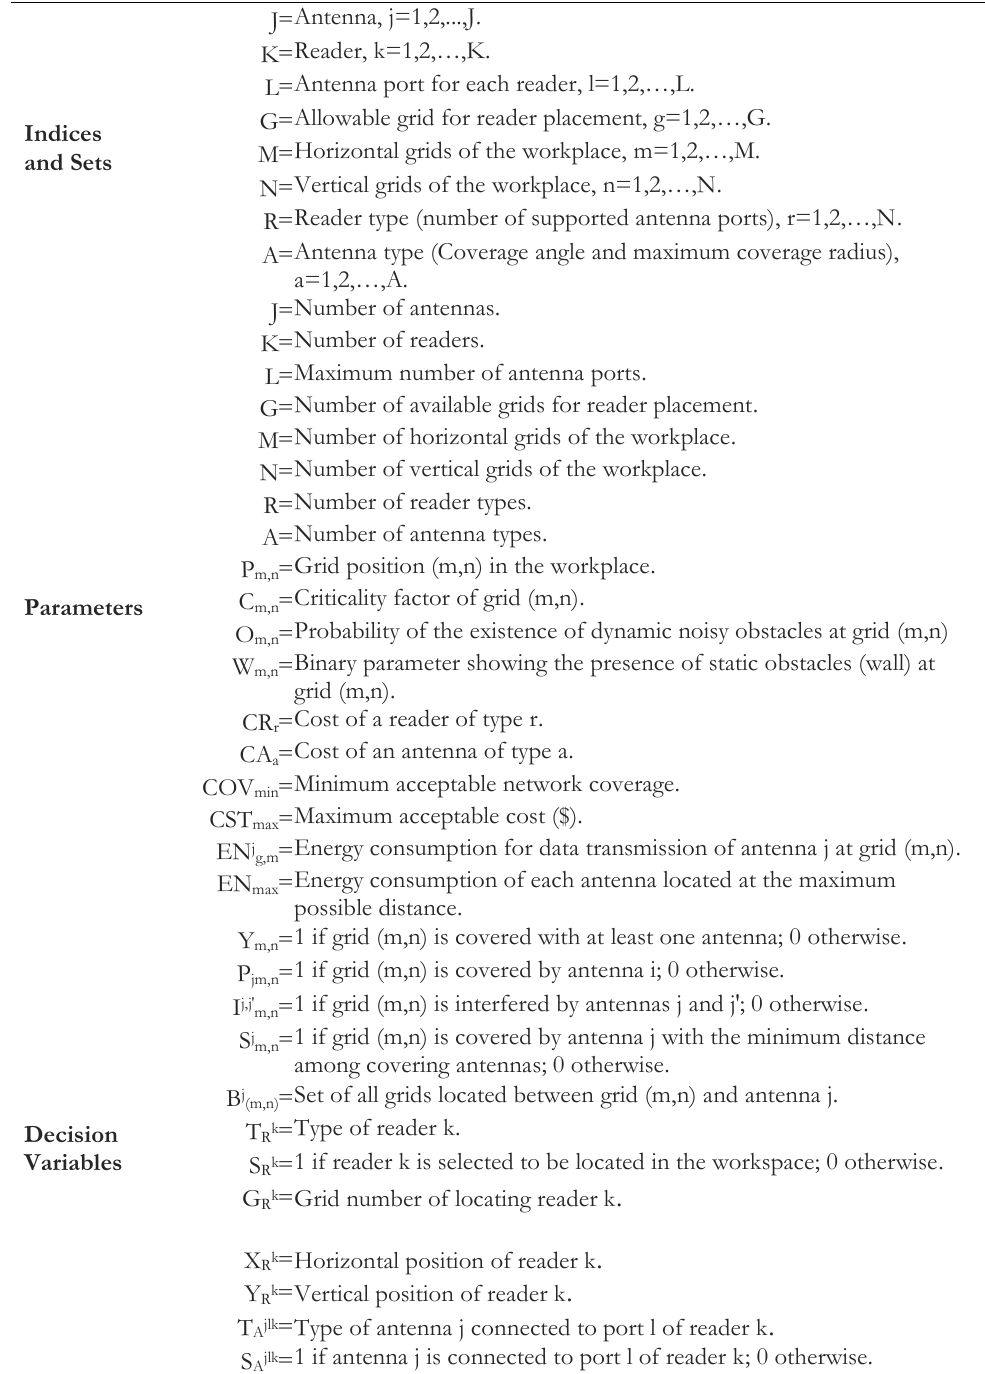
Table 2. List of indices, sets, parameters and decision variables of RNP